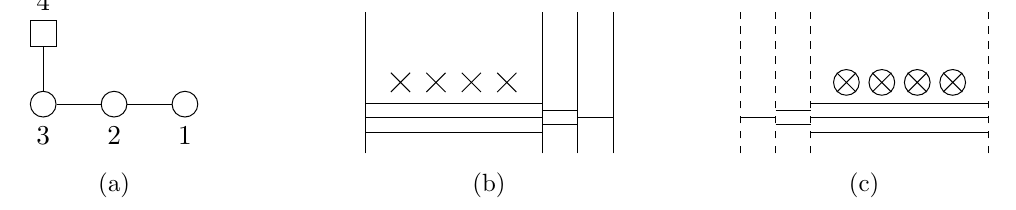
and M C = (cid:22) O , where (cid:22) O is the closure of (4) (4) (4)